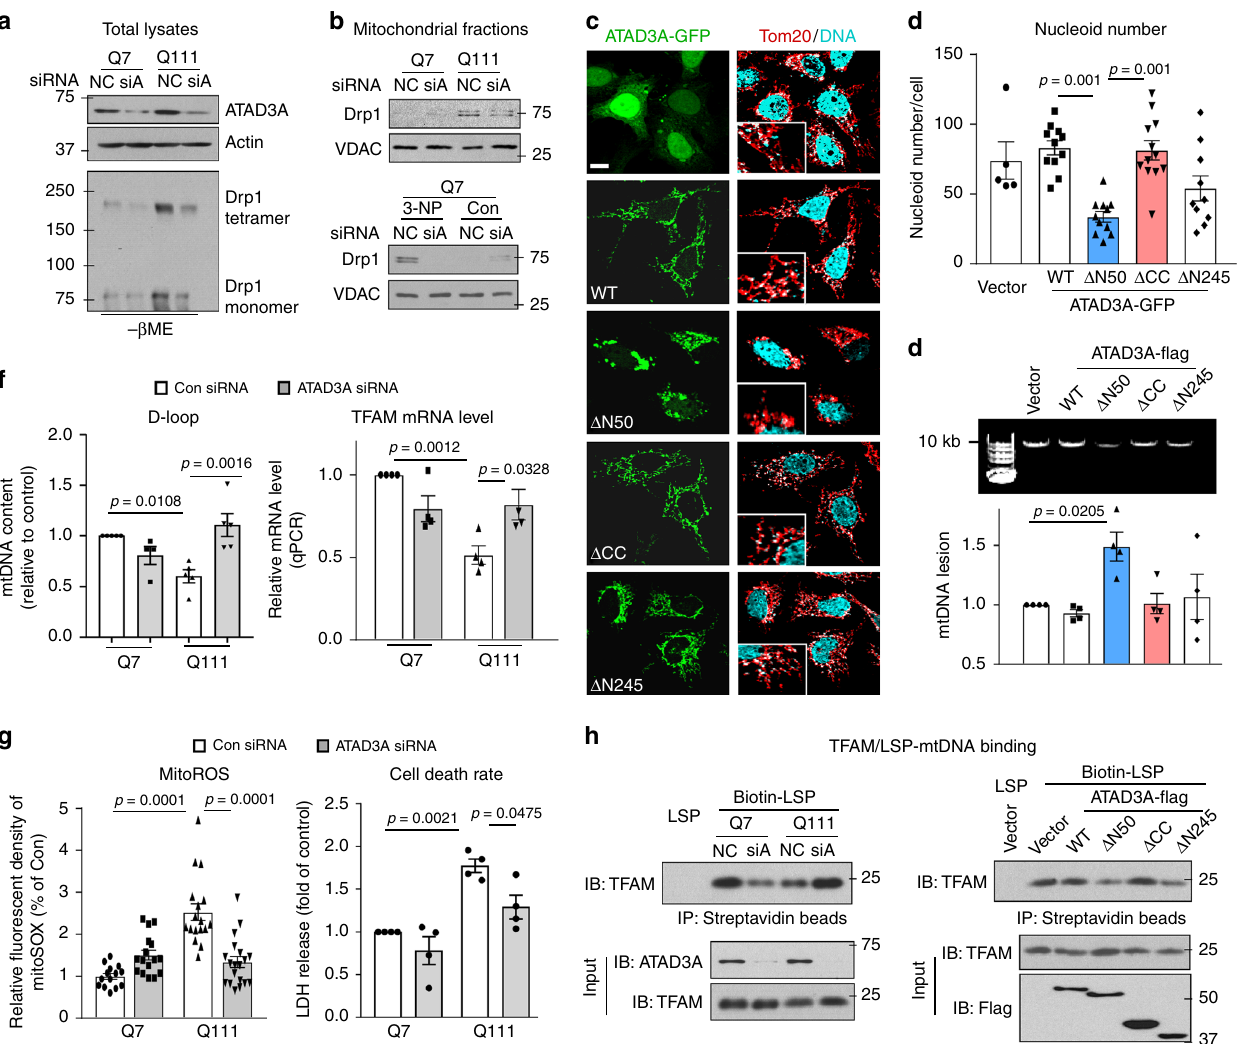
Fig. 3 ATAD3A oligomerization impairs mitochondrial fi ssion and mtDNA stability. HdhQ7 and Q111 cells were transfected with control siRNA (NC) or ATAD3A siRNA (siA) for 3 days. a Downregulation of ATAD3A was validated by WB. Actin: a loading control. Drp1 polymerization was analyzed by WB with anti-Drp1 antibodies in the absence of β -ME. b Mitochondria were isolated from HD striatal cells (Upper) and cells exposed to 5 mM 3-NP for 4 h (Lower). Drp1 mitochondrial level was analyzed by WB. Mitochondrial loading control: VDAC. c HeLa cells were transfected with ATAD3A-GFP truncated mutants, shown in Supplementary Fig. 3E, for 48 h. Cells were stained with anti-Tom20 (red) and anti-DNA (cyan) antibodies. The co-localization of DNA and Tom20 was analyzed by confocal microscopy. Insert: the enlarged images. Scale bar: 10 µ m. d The number of nucleoids immunopositive for both anti- DNA and anti-Tom20 was quantitated by NIH Image J software. 40 – 50 cells per group were analyzed. Three independent experiments, one-way ANOVA with Tukey ’ s post-hoc test. e Neuro2A cells were transfected with ATAD3A-Flag WT or mutants for 48 h, and total DNA was extracted for qPCR analysis to monitor the mtDNA lesion. Upper: Representative DNA agarose gel of the ampli fi cation of the 10 kb mtDNA fragment. Lower: The quanti fi cation of mtDNA lesion. Four independent experiments, one-way ANOVA with Tukey ’ s post-hoc test. f mtDNA content was analyzed by qPCR using primers from D-loop (left). TFAM mRNA level was analyzed by qPCR (right). At least 3 independent experiments, one-way ANOVA with Tukey ’ s post-hoc test. g Left: Cells were stained with mitoSOX fl uorescent probe to evaluate mitochondrial superoxide production (mitoROS). Right: Cell death rate was measured by LDH release into cytosol. Four independent experiments, one-way ANOVA with Tukey ’ s post-hoc test. h The binding of TFAM and biotinylated mtDNA LSP probe was determined by biotin-streptavidin pull down in HD striatal cells transfected with ATAD3A siRNA (left) and in Neuo2A cells expressing ATAD3A truncated mutants (right). All shown representative blots are from at least 3 independent experiments. All data are mean ± SEM expressing cells (Fig. 4f). Moreover, expression of K135E or peptides interfering with speci fi c protein – protein interactions can K135R mutant reduced the binding of mtDNA LSP to TFAM serve as pharmacological inhibitors to identify the role of inter- (Fig. 4g) and decreased the number of mitochondrial nucleoids acting proteins in the pathogenesis of human diseases. In a (Fig. 4h), suggesting mtDNA lesion. similar approach to the peptide designs for Drp1 peptide P110 7 or VCP peptide HV-3 31 , we used L-ALIGN sequence alignment software 32 and identi fi ed one region of homology between Drp1 Peptide DA1 blocks ATAD3A/Drp1 binding in HD . Next, we (human, NP_036192) and ATAD3A (human, NP_001164006) (Fig. 5a). The two regions were marked as region DA1 and DA2. assessed the functional signi fi cance of enhanced Drp1/ATAD3A Consistent with our domain mapping of Drp1-ATAD3A binding in HD pathology. We previously demonstrated that short NATURE COMMUNICATIONS| (2019) 10:1371